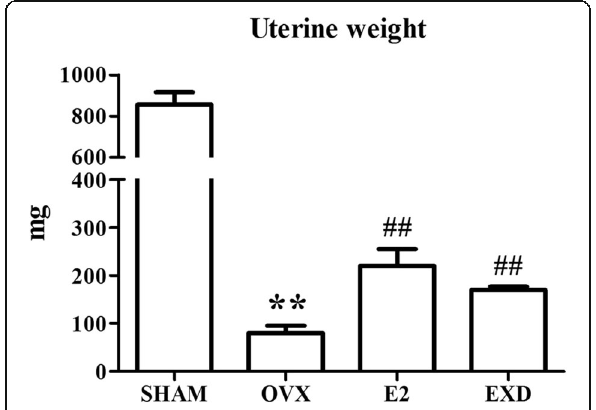
Fig. 2 Effect of EXD on uterine weight after 12-week treatment. ** P < 0.01 versus SHAM group; # P < 0.05 versus OVX group;